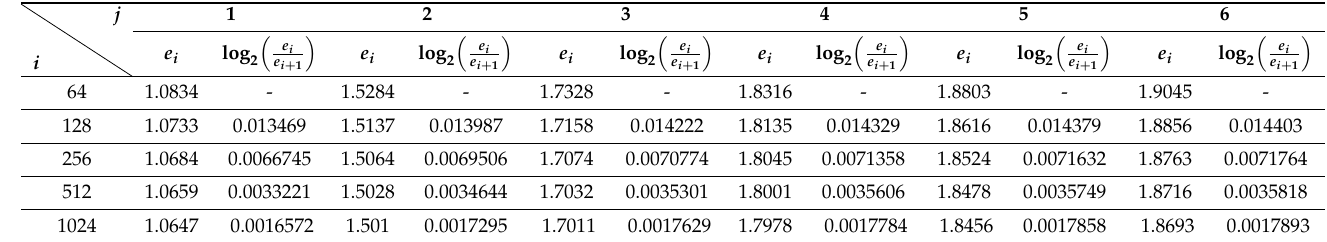
Table 3. Grid refinement analysis in the L ∞ norm for the numerical estimation of the order of approximation using j scales of subdivision. By i , we represent the number of initial control points that we use. We used the linear scheme (with M equal to the arithmetic mean in (3) and (4)) and the function in (24). For this piecewise continuous function, the greatest error is located at the discontinuity. Thus, the numerical errors presented in the table correspond to the errors at the discontinuity. We can see that they do not reduce as we refine the grid, reaching O ( 1 )